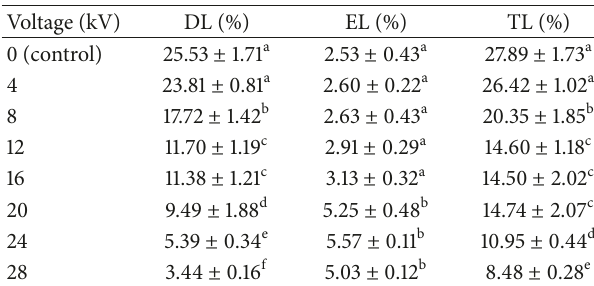
Table 2: The DL, EL, and TL of tofu under different